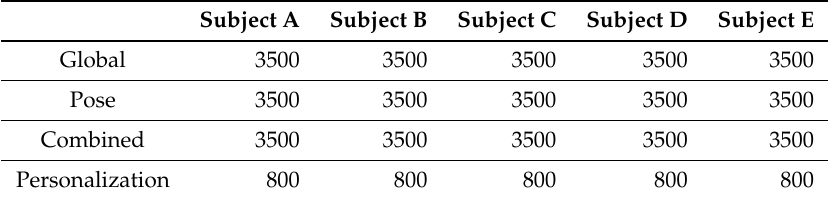
Table 1. Number of hand poses of every performer per